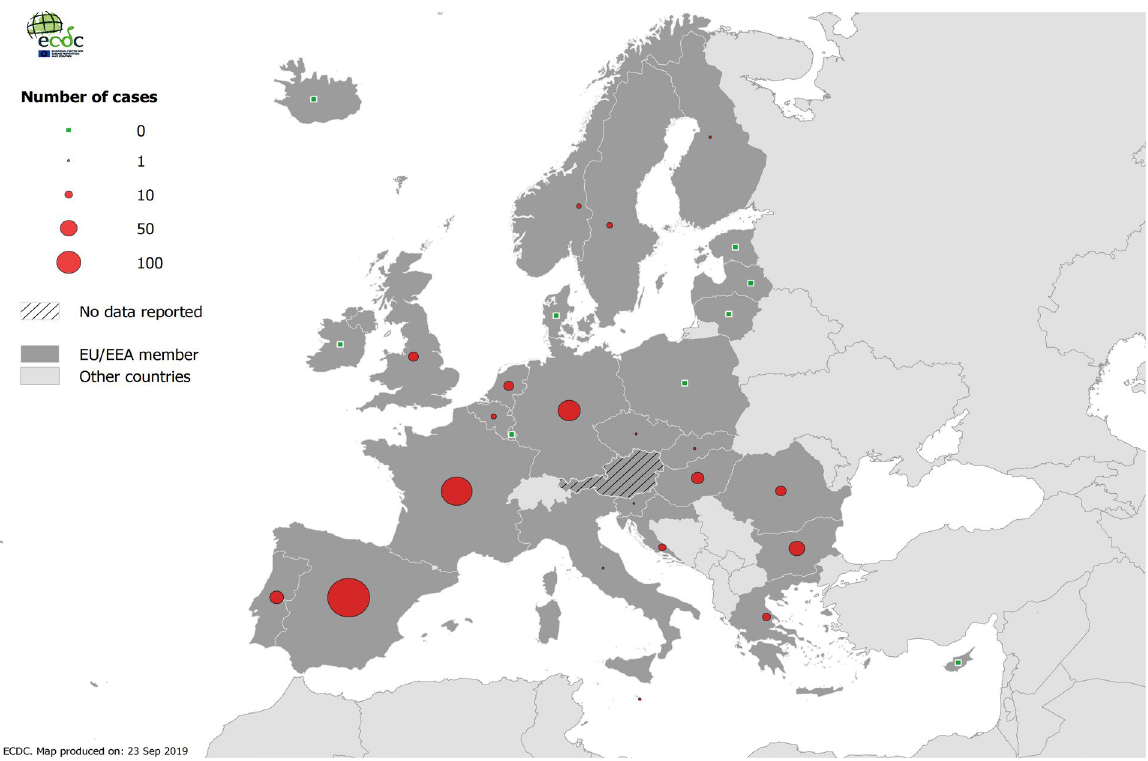
Figure 1. Distribution of confirmed Q fever cases by country, EU/EEA,